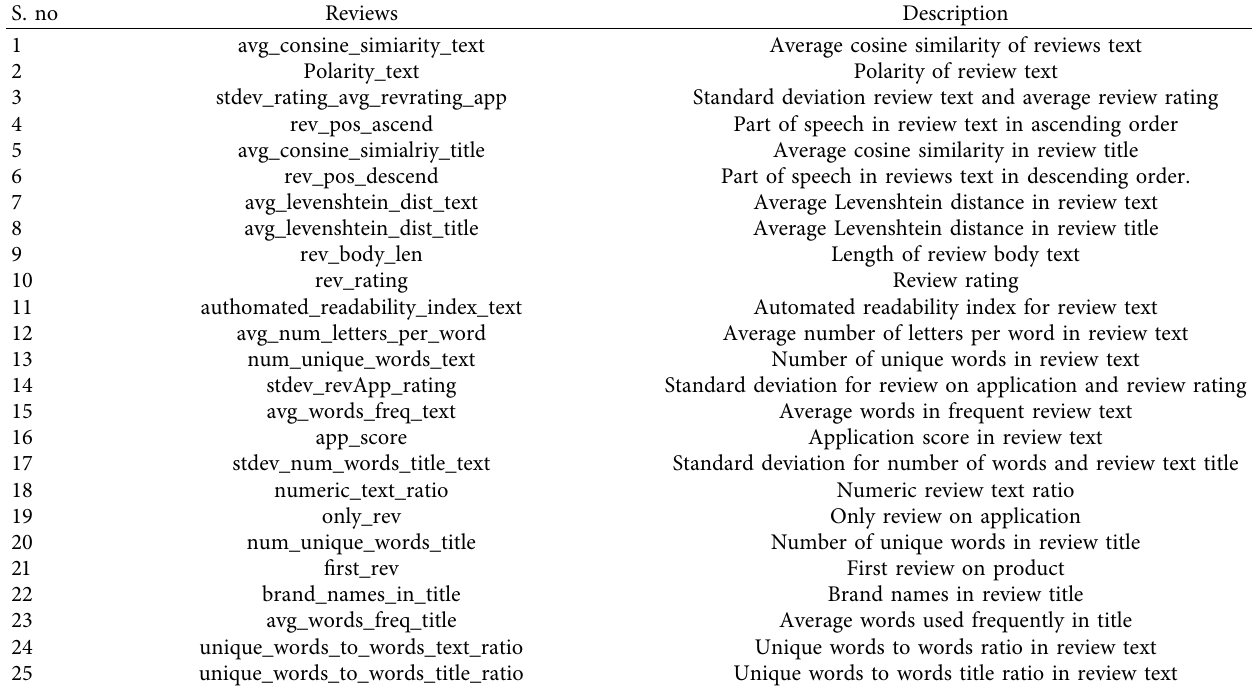
Table 2: All features in Yelp Dataset.